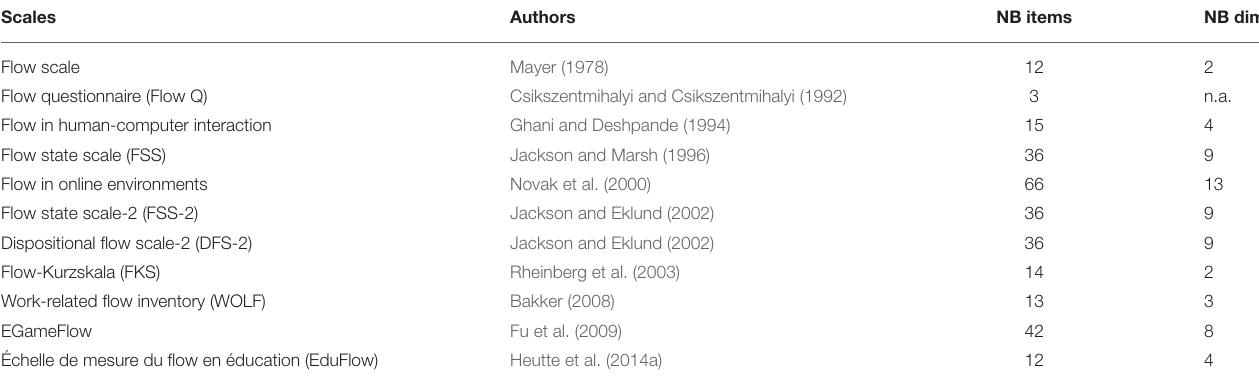
TABLE 1 | Some examples of tools used to study on flow in an educational context. Scales